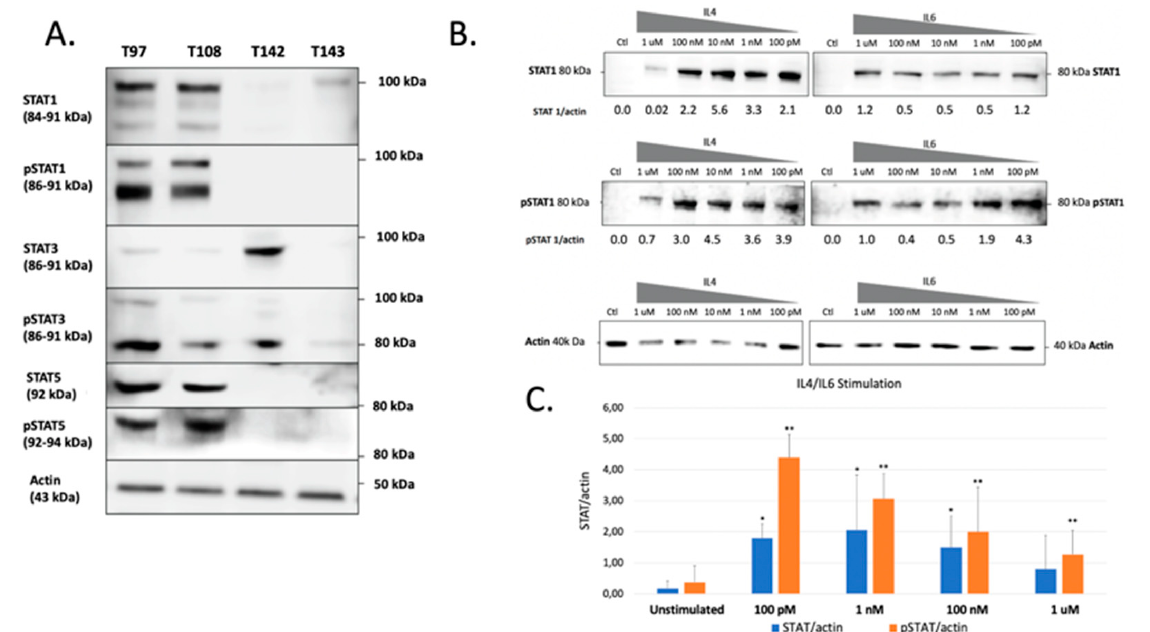
Figure 3. Western blot analysis of total and phosphorylated STAT1, STAT3 and STAT5 in UM cell lines. ( A ) Proteins from the UM cell lines T97, T108, T142 and T143 were Western blotted using antibodies that recognize only the phosphorylated (phospho-STAT1, phosphor-STAT3 and phosphor-STAT5) or total (comprising both inactive and phosphorylated) STAT1, STAT3 or STAT5 proteins (STAT1, STAT3 and STAT5). T97 and T108 UM cells express phosphorylated STAT1, STAT3 and STAT5